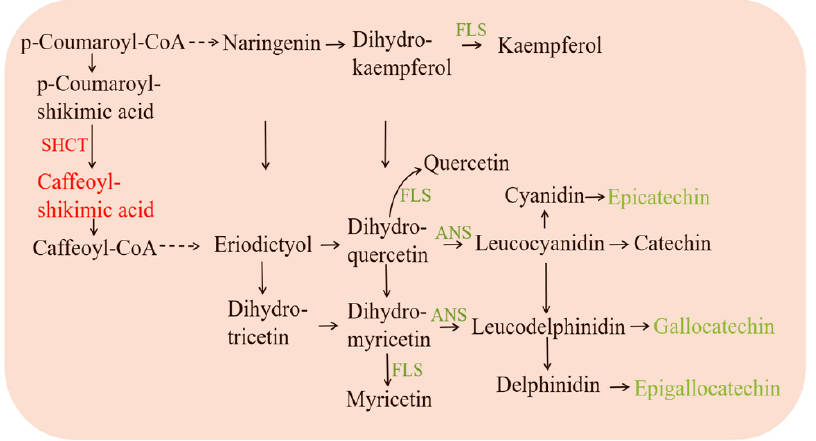
Figure 8. Flavonoid metabolism in pea intercropped tea plants. The red and green colored text indicate up- and down-regulated genes or metabolites, respectively.